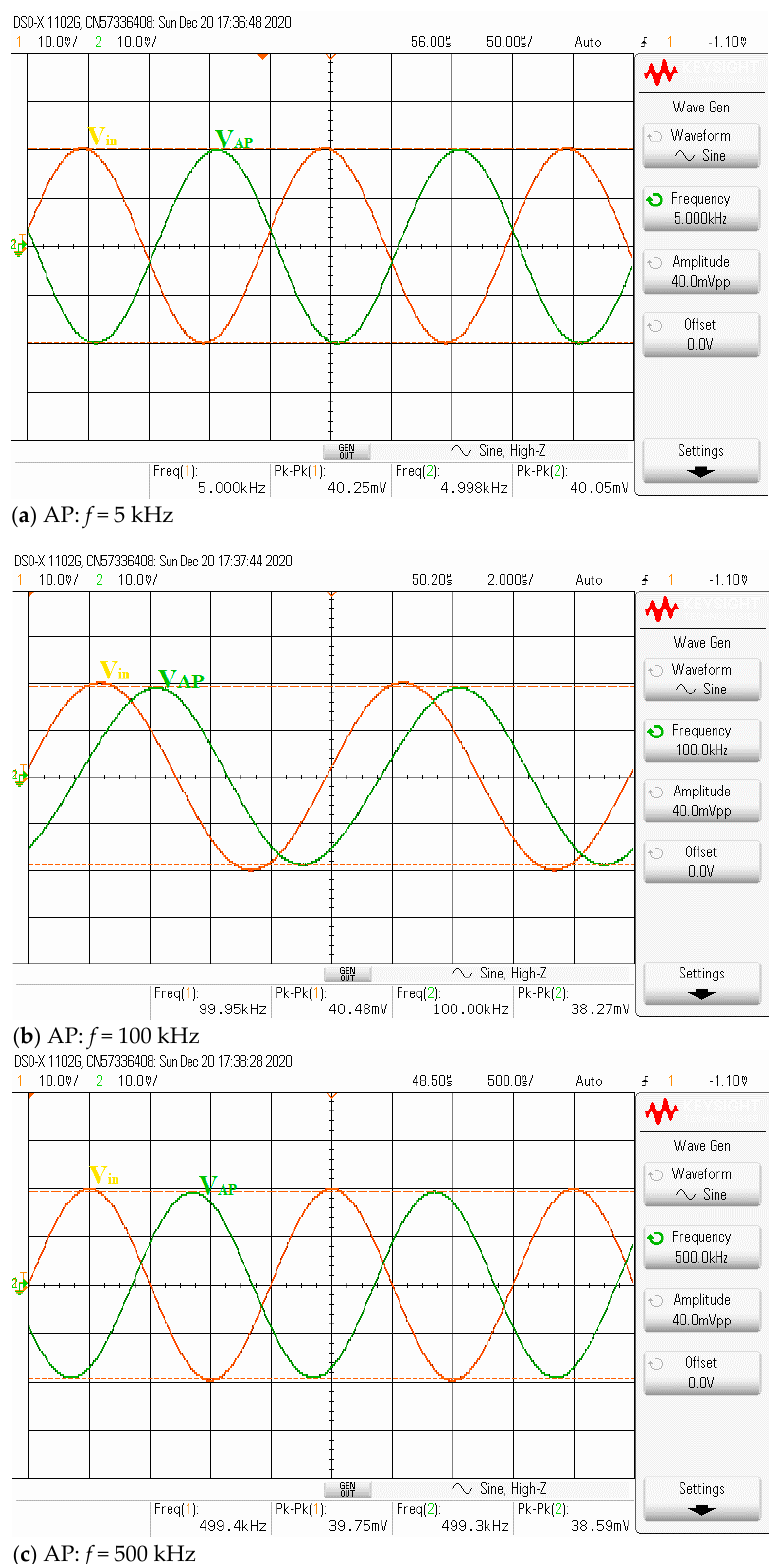
Figure 24. Experimental gain and phase response of the AP filer ( I B1 = I B2 = 200µA, R 1 = 1 k and C 1 = C 2 = 5.5 nF).